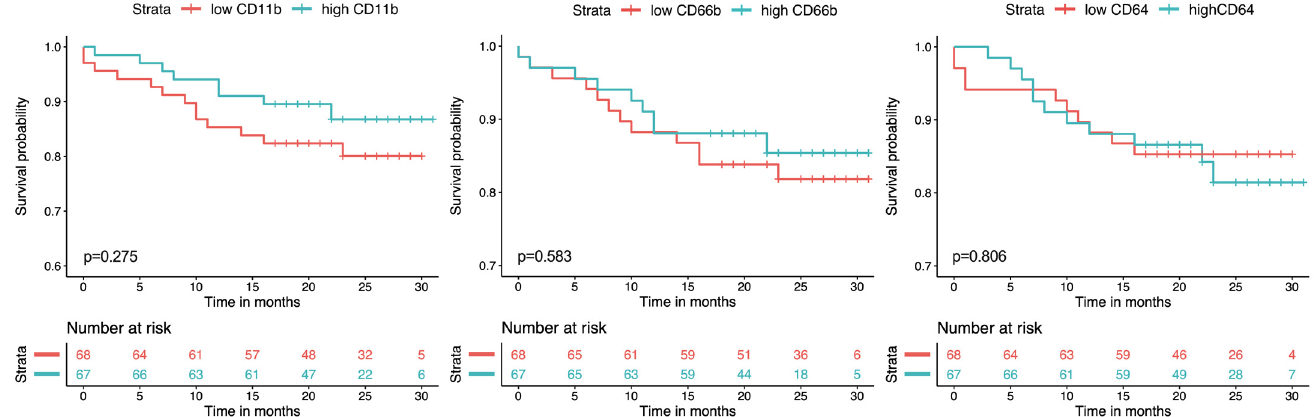
Figure 3. Kaplan–Meier analysis for the outcome all-cause mortality with low and high expression of neutrophil activation/maturation markers with the median mean fluorescence intensity (MFI) as the cut-off value. Comparison was calculated by the log-rank test.